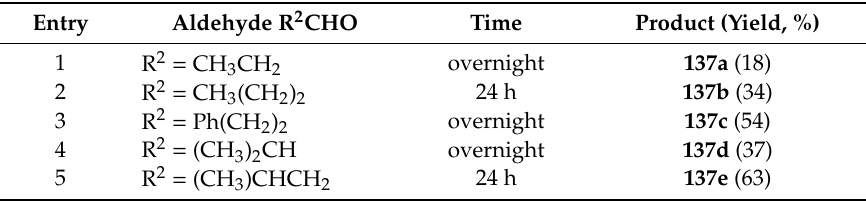
Table 10. Reaction time and yields of oxiranylketones 136a – e obtained from ketoselenonium ylide 134a and aliphatic aldehydes.